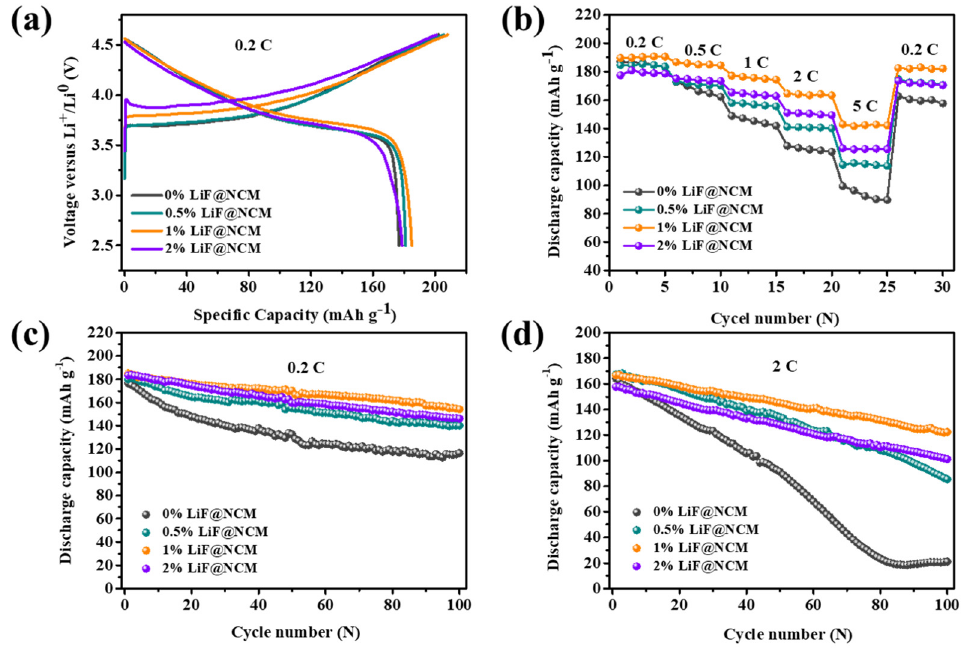
Figure 7. The electrochemical properties of 0%LiF@NCM, 0.5%LiF@NCM, 1%LiF@NCM, and 2%LiF@NCM: ( a ) the initial charge-discharge curves at 0.2C; ( b ) rate performance from 0.2C to 5C; ( c ) cycling performances at 0.2C; ( d ) cycling performances at 2 C.